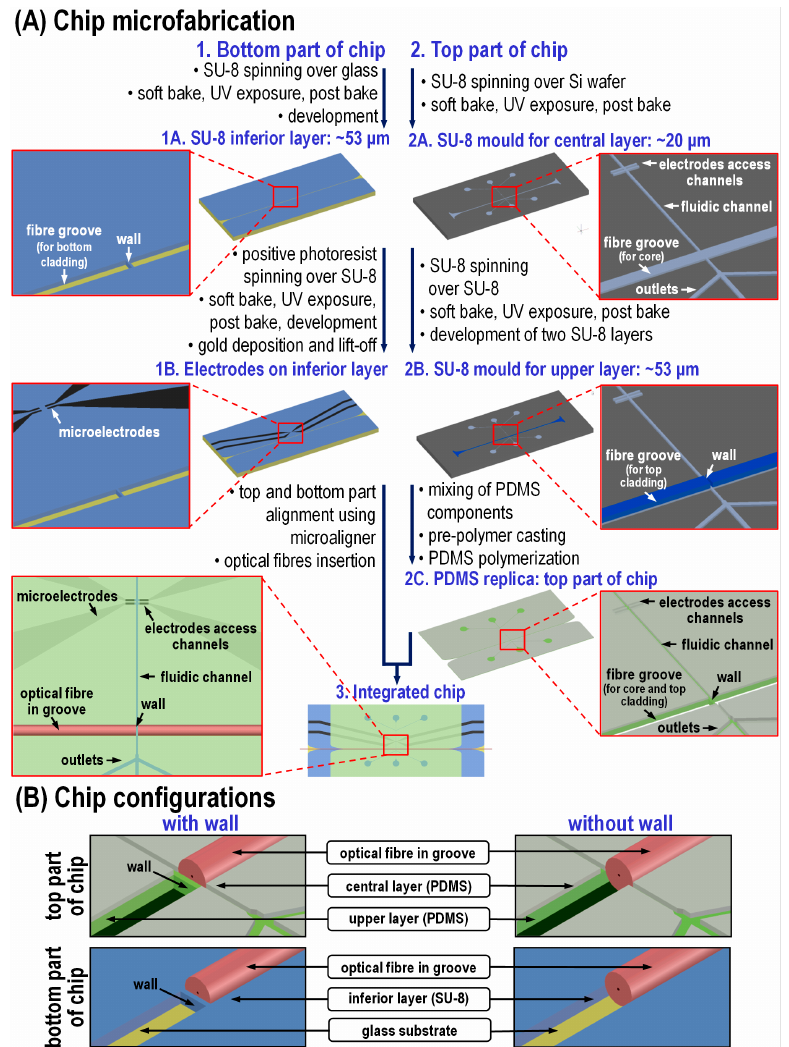
Figure 2. Construction details of the hybrid microfluidic chip: ( A ) microfabrication process (the bulk part of the PDMS is not shown so as not to darken the images) and ( B ) 3D schema of the optical detection area showing the configuration with the wall ( left ) and without the wall ( right ) in between the optical fibers (125 μm diameter) in the upper and inferior layers. The top part of the chip is placed upside-down on the bottom part of the chip forming a sandwich of a total fiber groove depth of 126 μm.